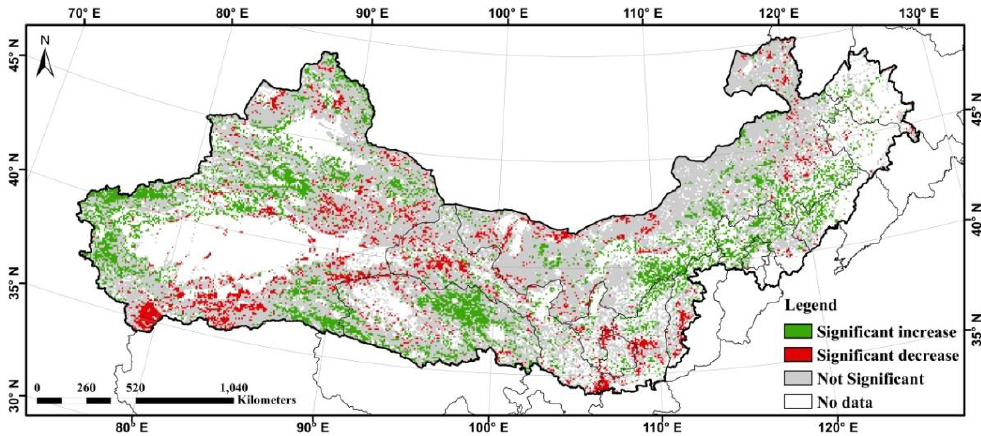
Figure 4. Spatial pattern of significant change for the accumulated NDVI in growth seasons from 1982–2006.